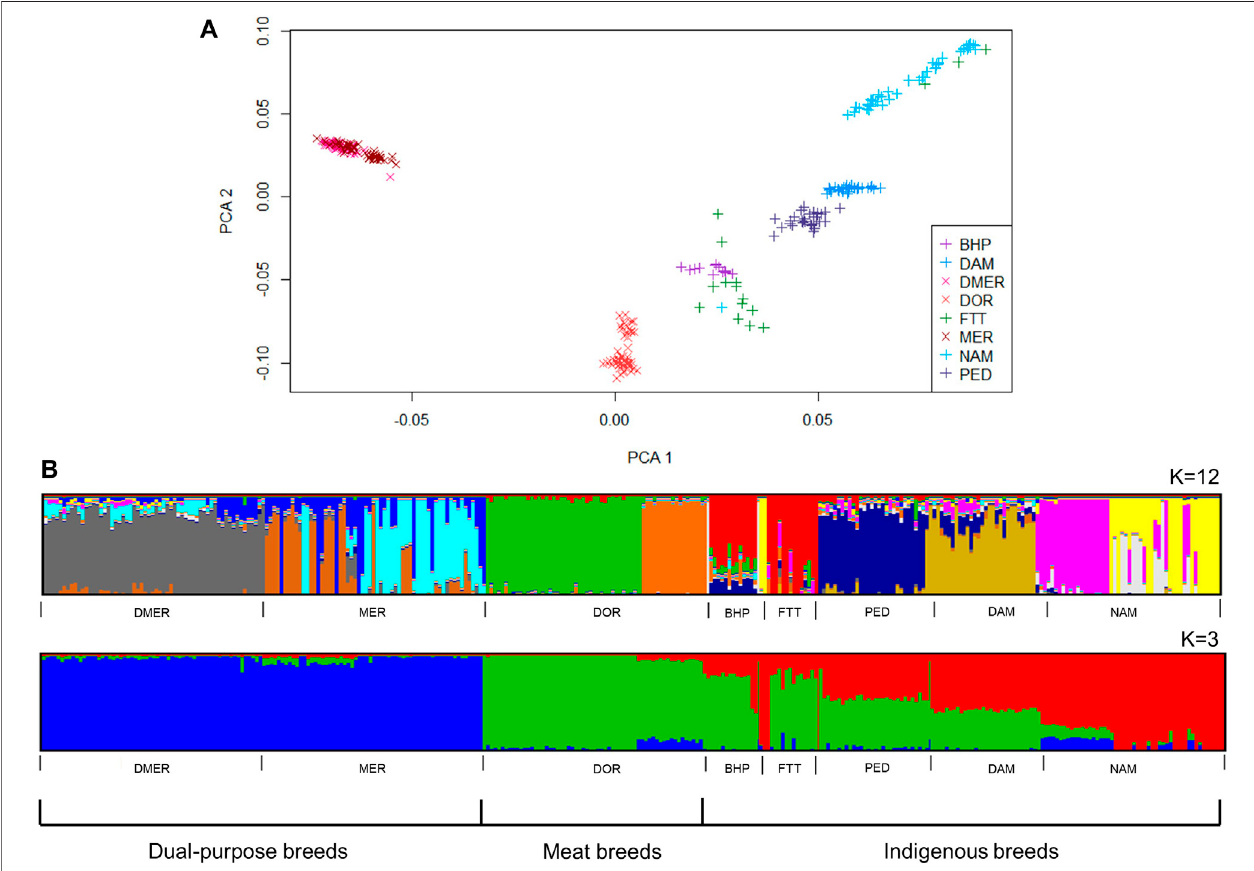
FIGURE 4 | Genetic structure of South African sheep breeds, according to model-based clustering (A) and principle component analysis (B) .